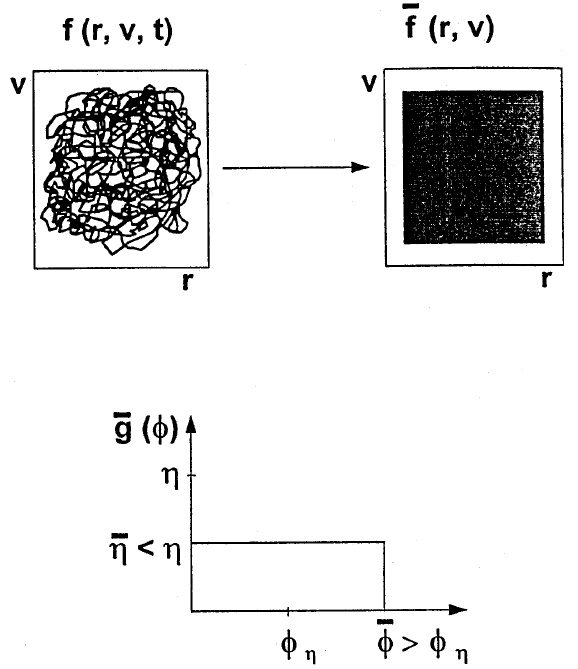
Fig. 6. Sketch of a simple distribution function filamentating in phase space ( left ) and the corresponding coarse-grained distribution function on macroscopic scales ( right ). Due to the averaging the value of the distribution function is decreased, the occupied volume increased. The consequences for the corresponding reduced distribu- tion function is schematically shown at